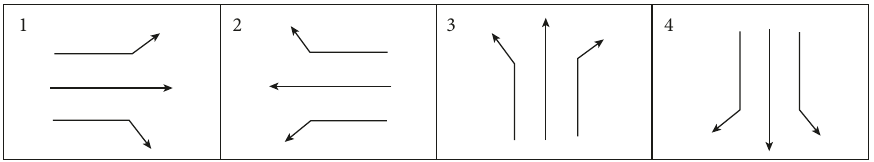
Figure 4: Phase diagram of the subject intersection.